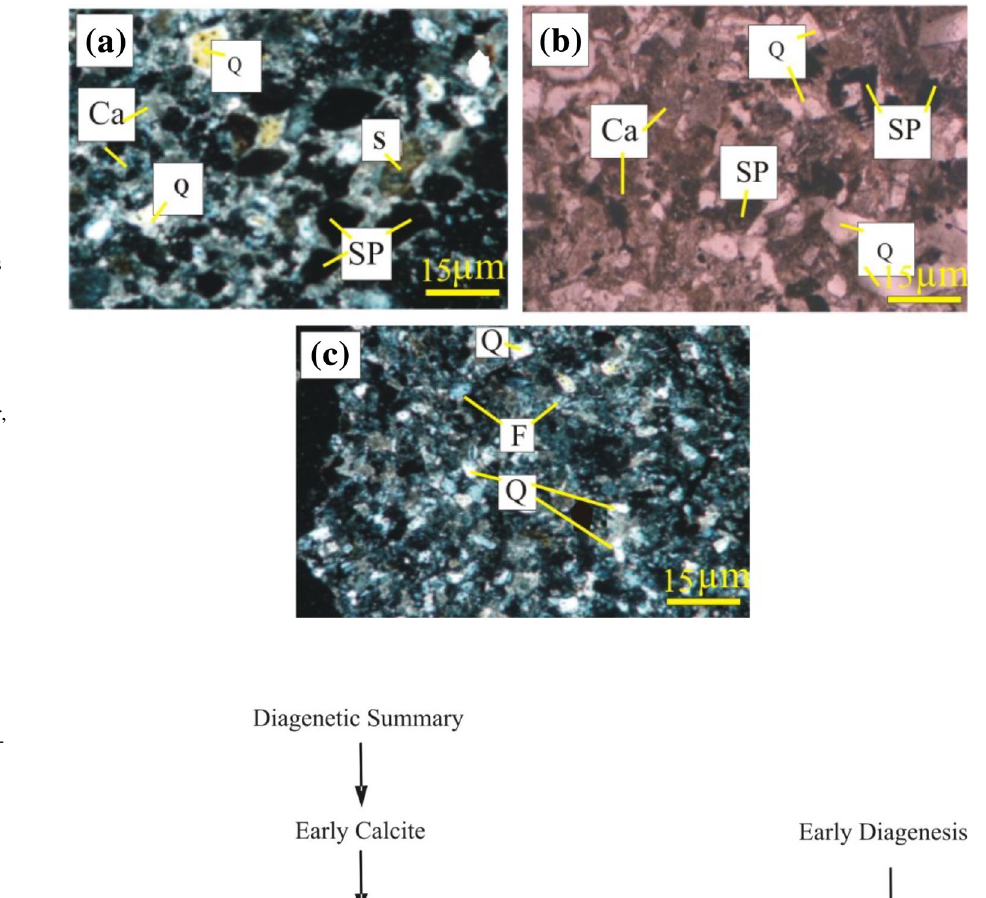
Fig. 4 Micrographs of the Penek Formation sandstones.